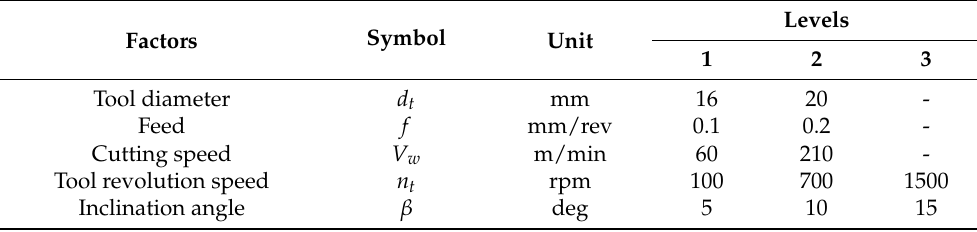
Table 2. Input cutting parameters (factors) of turning with the ADRT and their levels.